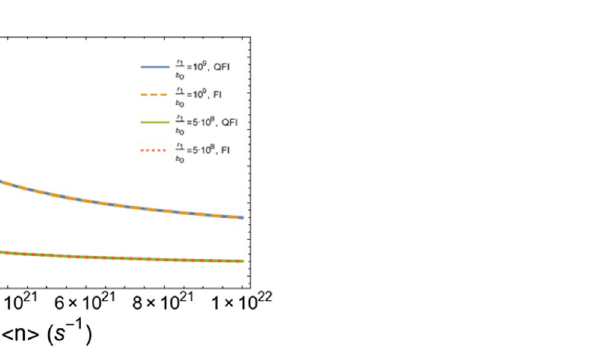
Figure 2. Figure of merit of the sensitivity of our scheme vs. average number of photons per second for = 10 11 , r = 10 2 and two different values of L in the range of millions of km. In both cases λ = 10 3 nm, r 1 / b 0 1 / L we plot both the optimal bound provided by the QFI and the FI of homodyne detection, which turn out to be practically indistinguishable.